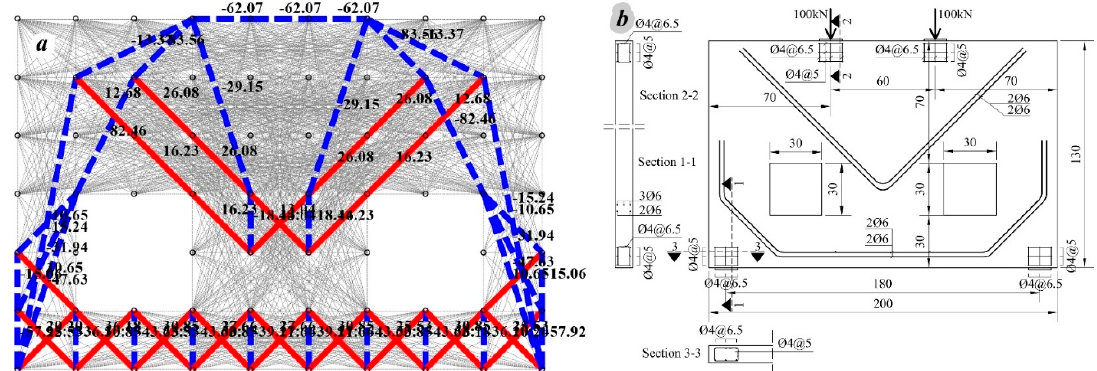
Figure 8. ( a ) Strut-and-Tie model for W3, ( b ) reinforcement layout.